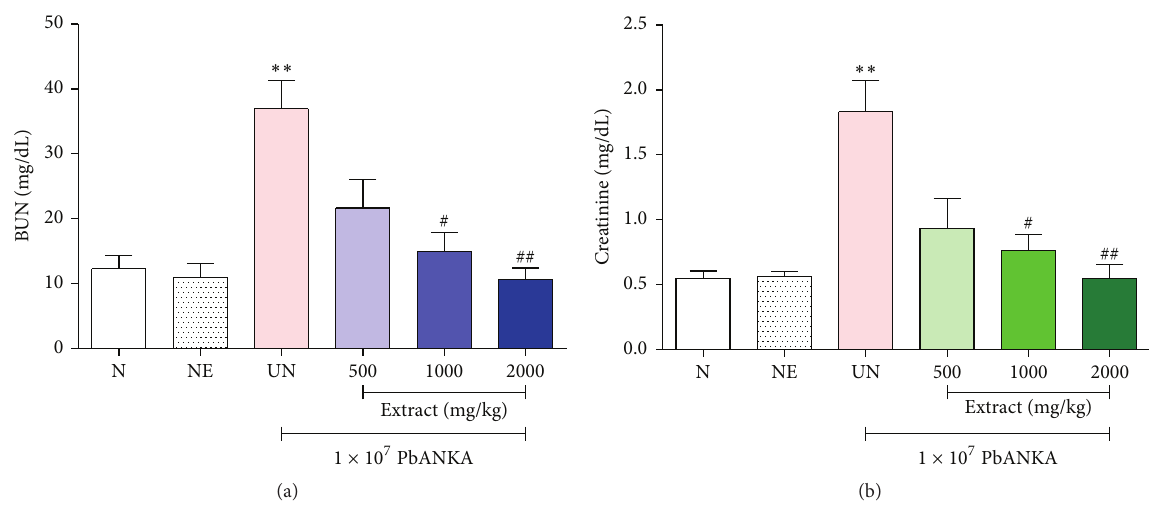
Figure 2: Protective effect of aqueous crude extract of neem leaves on renal injury induced by Plasmodium berghei infection in mice. Groups of ICR mice (5 mice of each) were infected with 1 × 10 7 parasitized erythrocytes of PbANKA by IP injection and given 500, 1,000, and 2,000 mg/kg of neem leaf extracts orally for 4 consecutive days. On day 5 of experiment, (a) BUN and (b) creatinine levels were measured and compared to normal and untreated groups. Results were expressed as mean ± SEM. ∗∗ 𝑃 < 0.01 , compared to normal group, # 𝑃 < 0.05 and ## 𝑃 < 0.01 , compared to untreated group. N: normal mice, NE: normal mice treated with 2,000 mg/kg of neem leaf extract, and UN: untreated